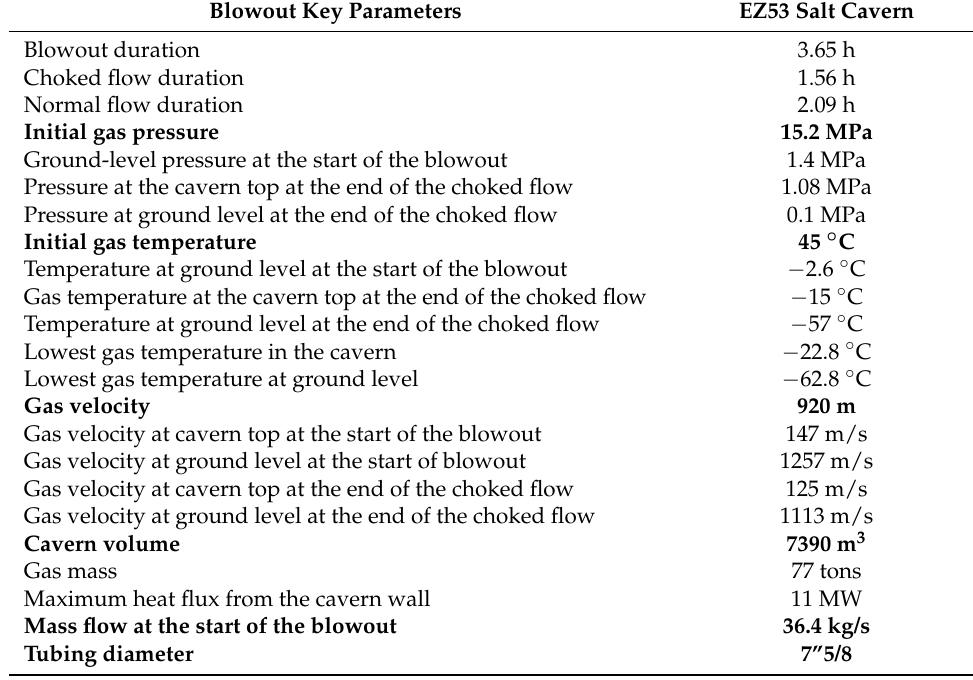
Table 5. Summary of the results of blowout analysis on the EZ53 salt